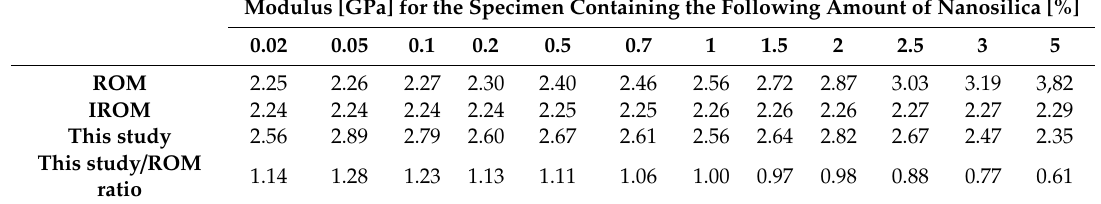
Table 4. Theoretical values calculated based on rule of mixtures (ROM) and inverse rule of mixtures (IROM) compared to average elastic moduli obtained in this